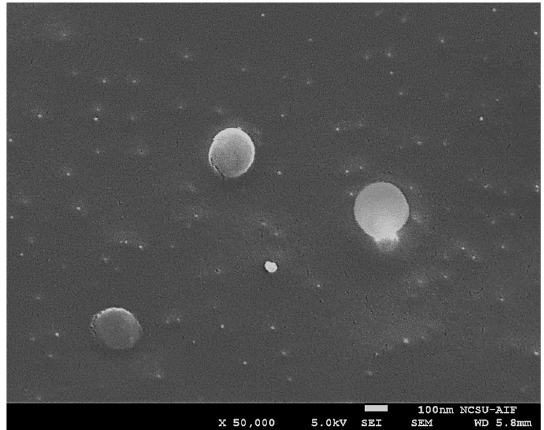
Figure 3. A Cryo-SEM image of the Ch-LNPs showing their approximate size and spherical